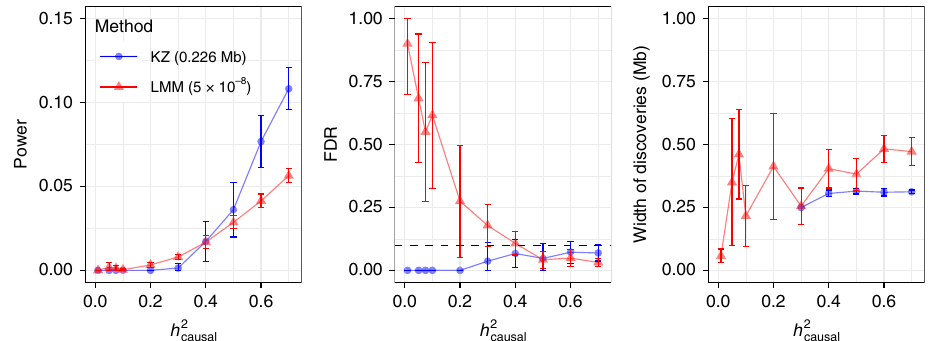
Fig. 6 Locus discovery in a simulated case – control study. Locus discovery with KnockoffZoom and BOLT-LMM for a simulated case – control study. There are 500 evenly spaced causal variants. The error bars indicate 95% con fi dence intervals for the mean power and FDR, as de fi ned in Fig. 3a, averaging 10 independent replications of the trait given the same